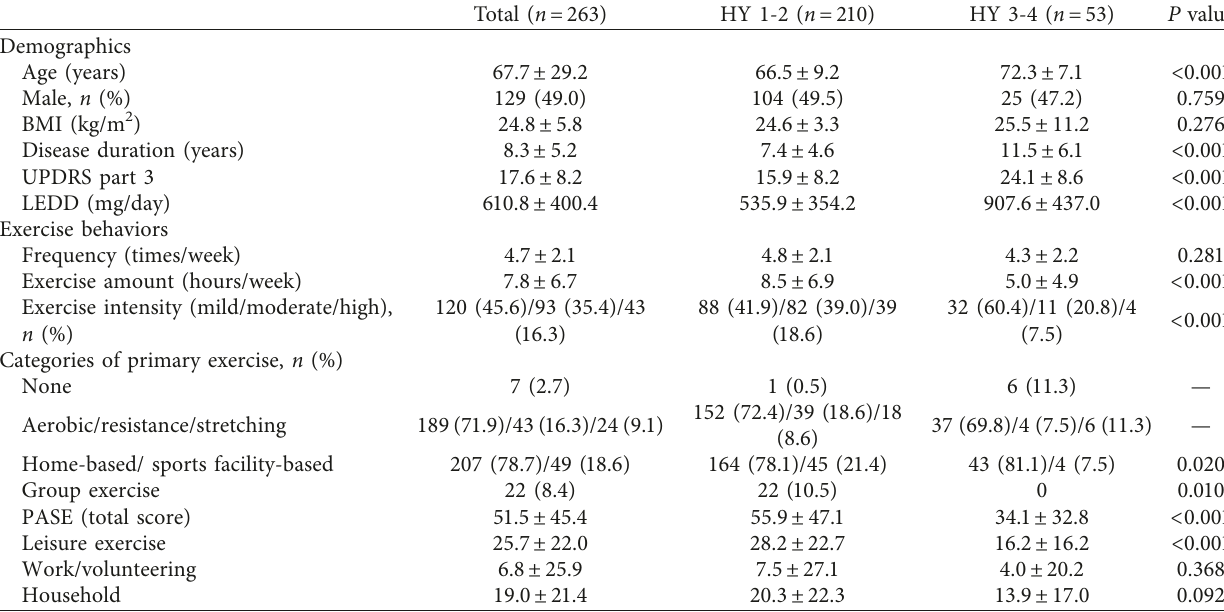
Figure 1: Flowchart to describe the enrolled study population. Table 1: Demographics, exercise patterns, and PASE scores of Parkinson’s disease